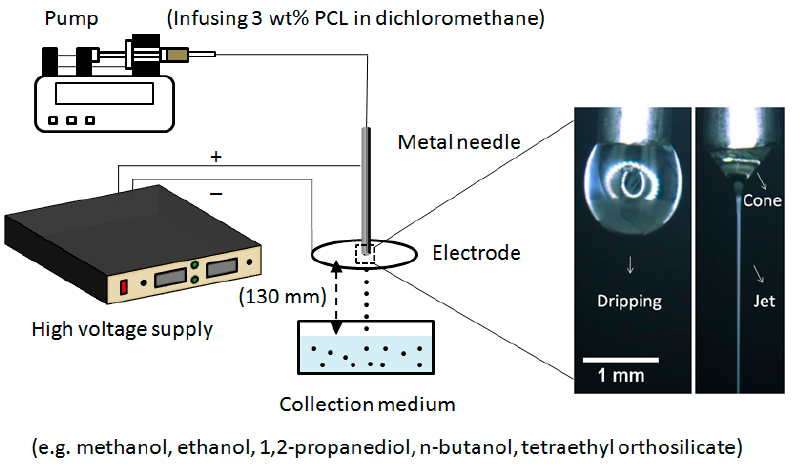
Figure 1. Schematic illustration of typical electrospraying (ES) setup. The inset shows two Figure characteristic jetting modes during ES: dripping mode and cone-jet mode.